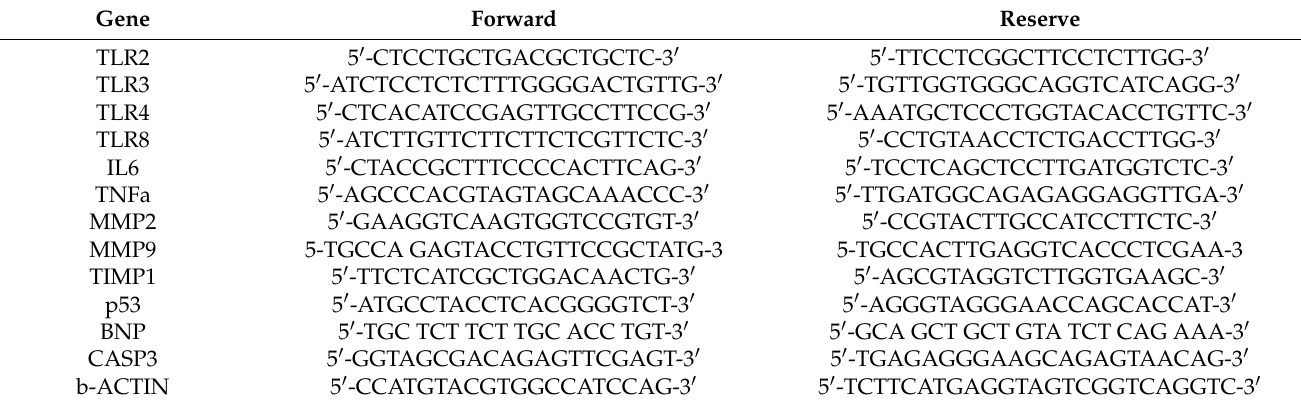
Table 1. Primers for real-time polymerase chain reaction (PCR) for each